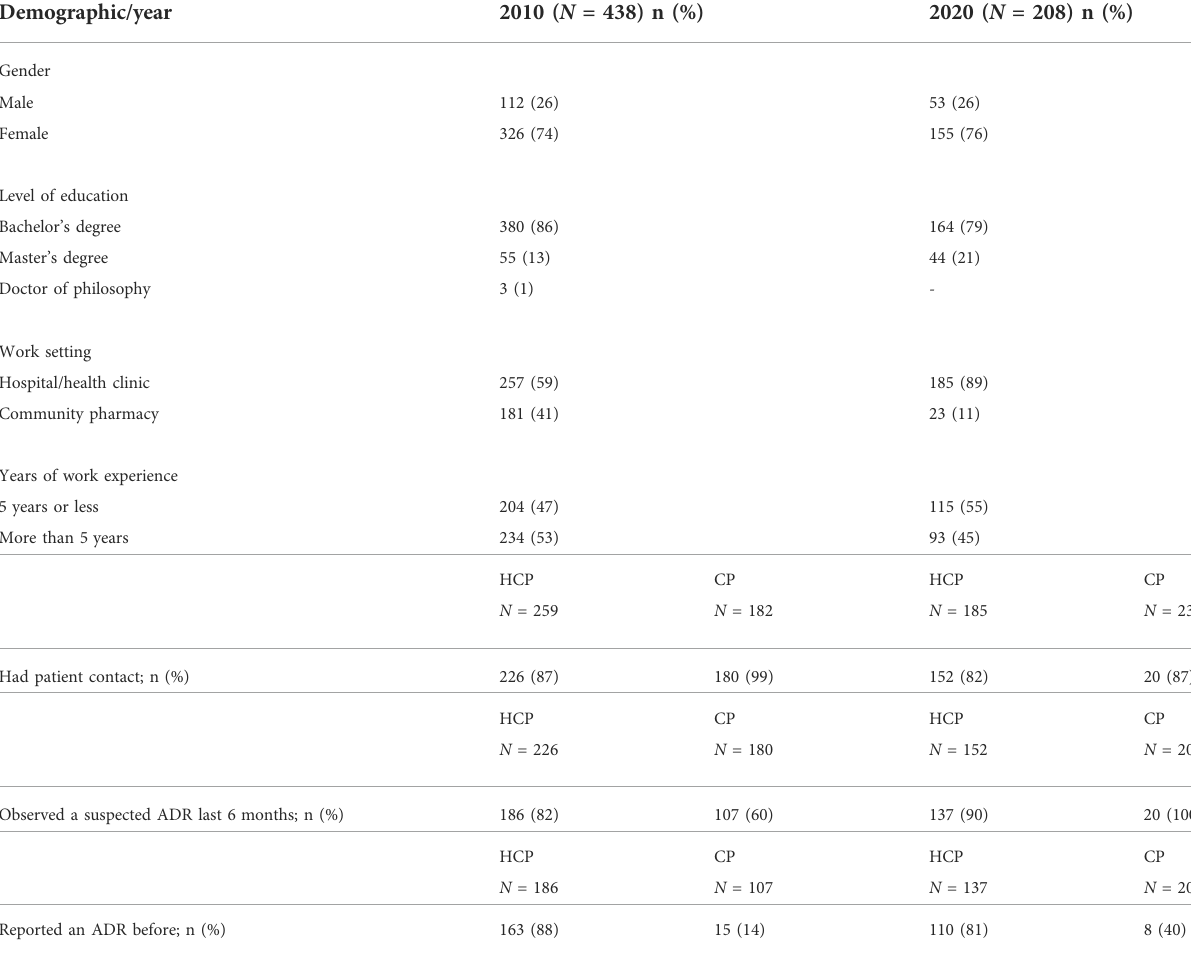
TABLE 1 Demographic data of pharmacists in 2010 and